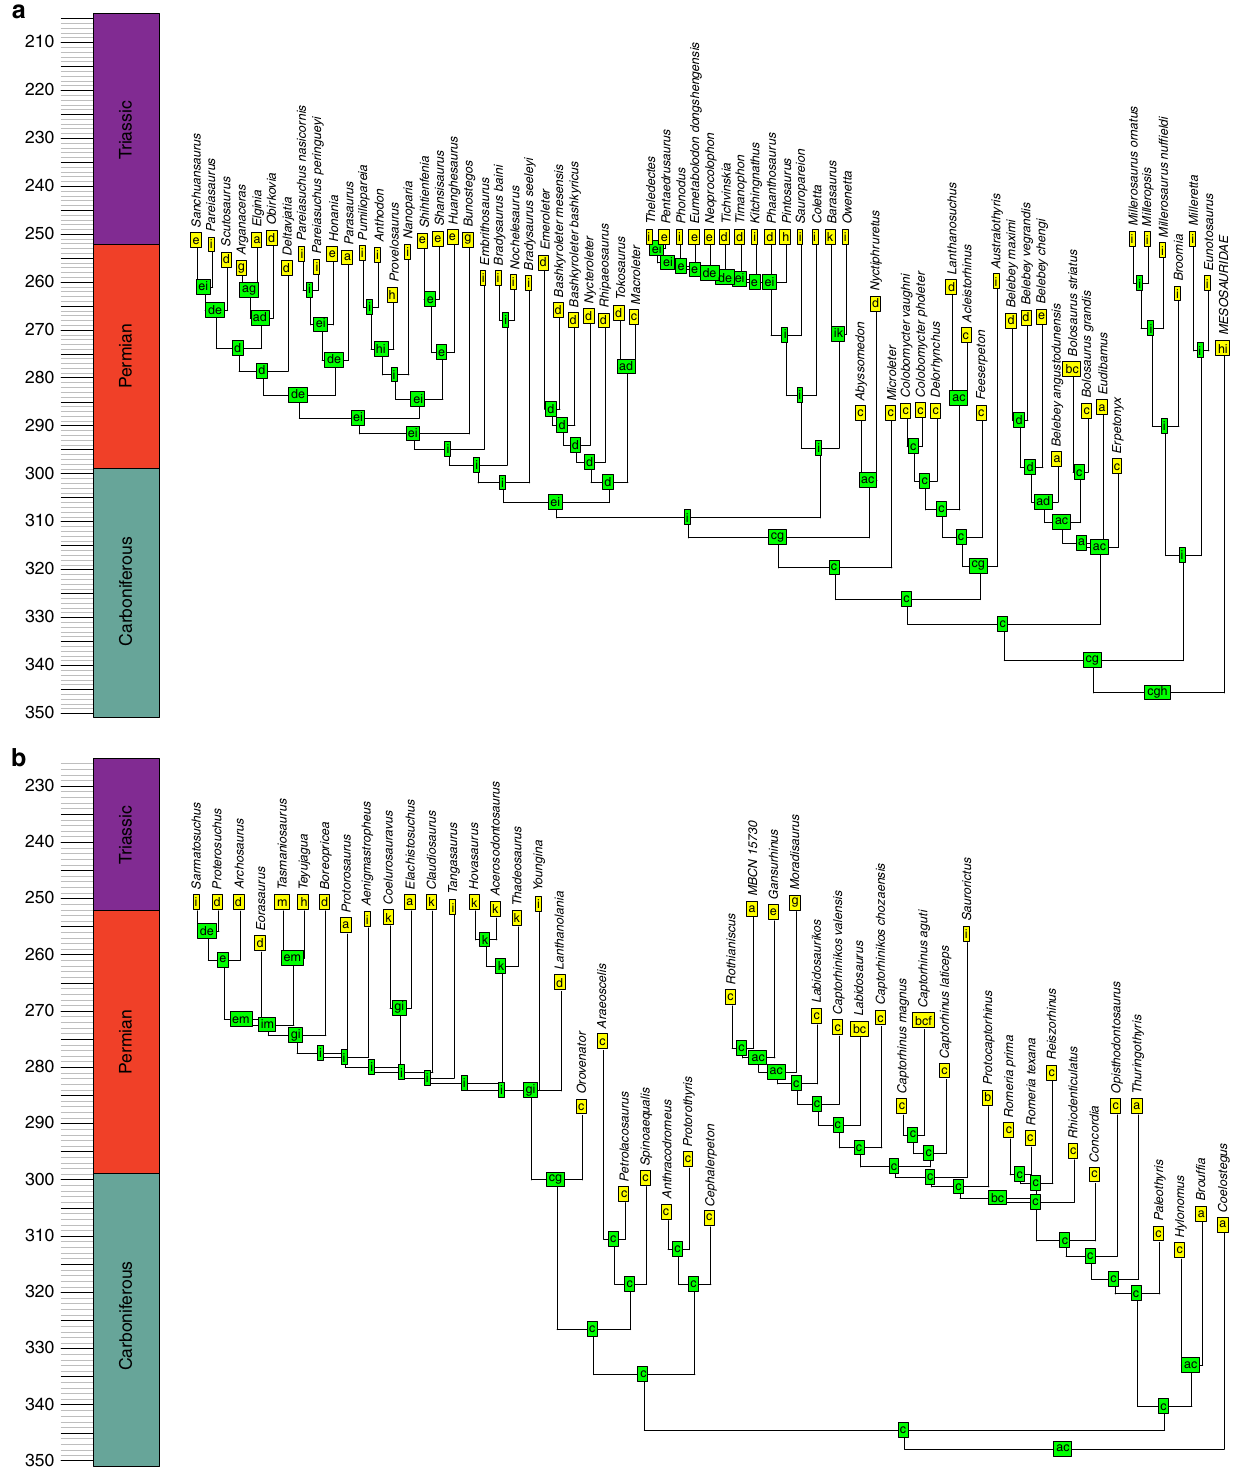
Fig. 6 Example of a reconstruction of ancestral geographic ranges of sauropsids. Tree was randomly selected from the 100 time calibrated trees. a Parareptilia. b Eureptilia. Node labels represent the geographic range of that node with the highest probability, deduced by BioGeoBEARS. a = Western Europe; b = Western North America; c = Eastern North America; d = Eastern Europe; e = East Asia; f = Northern South America; g = Northern Africa; h = Southern South America; i = Southern Africa; j = Antarctica; k = Madagascar; l = India; m =